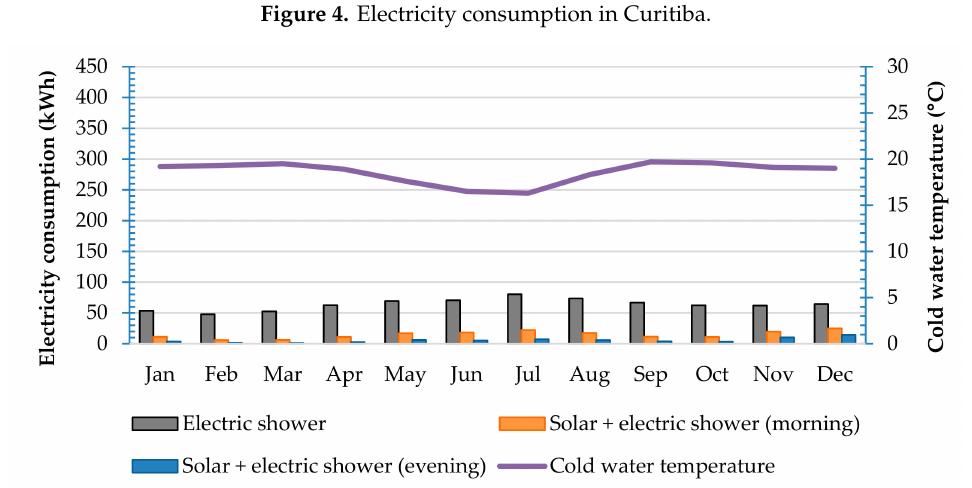
Figure 5. Electricity consumption in Bras í lia.